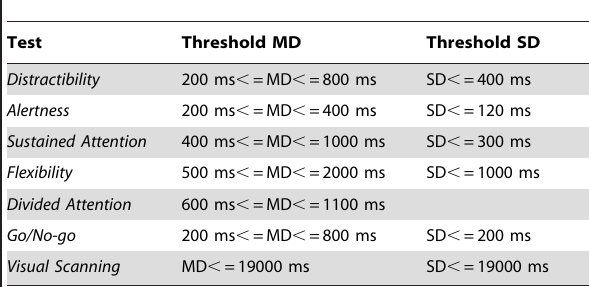
Table 4. Thresholds for exclusion of outliers for the median (MD) of reaction time (RT) in milliseconds (ms), with standard deviations (SD) for different subtests of the KITAP